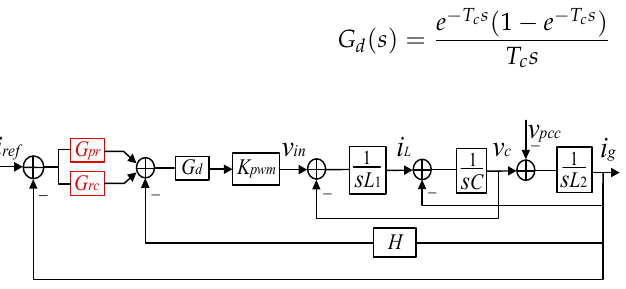
Figure 2. Control structure diagram of grid ‐ connected LCL inverter.